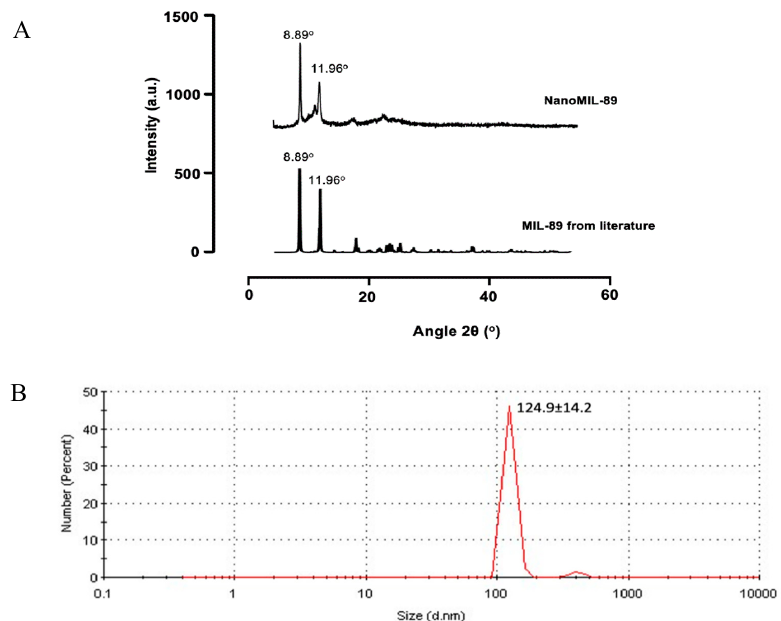
Figure 1. Characterization of nanoMIL-89 using ( A ) Powder X-ray Di ff raction (PXRD) comparing the synthesized nanoparticle pattern [25] with the Materials Institut Lavoisier-89 MIL-89 pattern reported in the literature by literature by Horcajada.et.al (2006). ( B ) nanoMIL-89 estimated gyration diameter using Dynamic Light Scattering (DLS)